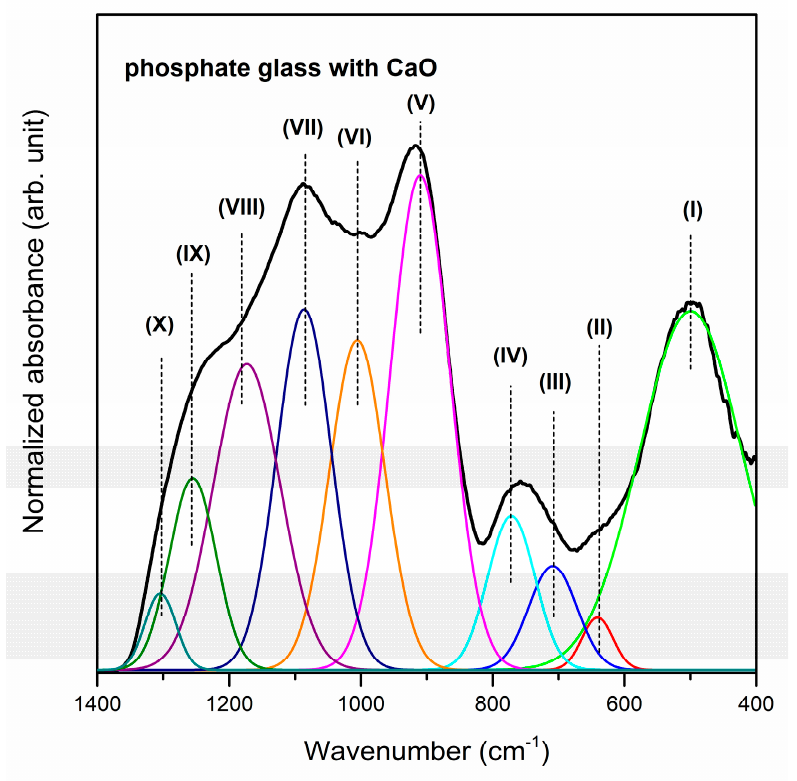
Figure 1. Deconvoluted near-infrared spectra of phosphate glass with CaO as oxide glass modifier.